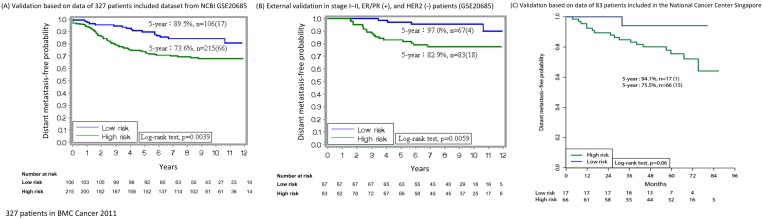
External validation of 18-GC.(A) Validation based on data of 327 patients included dataset from NCBI GSE20685, ID: 200020685. Time to distant metastasis by the 18-gene scores: The 5-year rate of DMFP in patients with scores of <21 was 89.5% (95% CI, 81.9%–94.1%) and the rate in patients with scores of ≥21 was 73.6% (67.2%–79.0%). (B) External validation in stage I–II, ER/PR (+), and HER2 (-) patients (GSE20685). Time to distant metastasis by 18-gene scores (n = 150): the 5-year DMFP (95% CI) <21: 97.0% (88.5%–99.2%), n = 67 (4); ≥21: 82.9% (72.9%–89.5%), n = 83 (18). (C) Validation based on data of 83 patients included in the National Cancer Center Singapore. Five-year rates of DMFP in the low- and high-risk patients are shown.